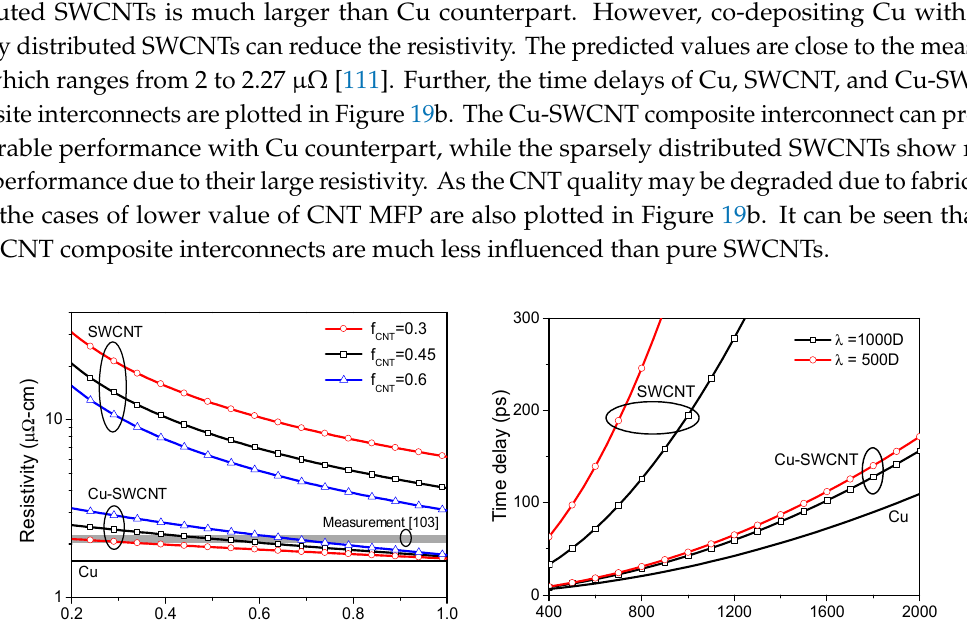
Table 1. Comparison of Cu, GNR, CNT, Cu-graphene, and Cu-CNT interconnects.